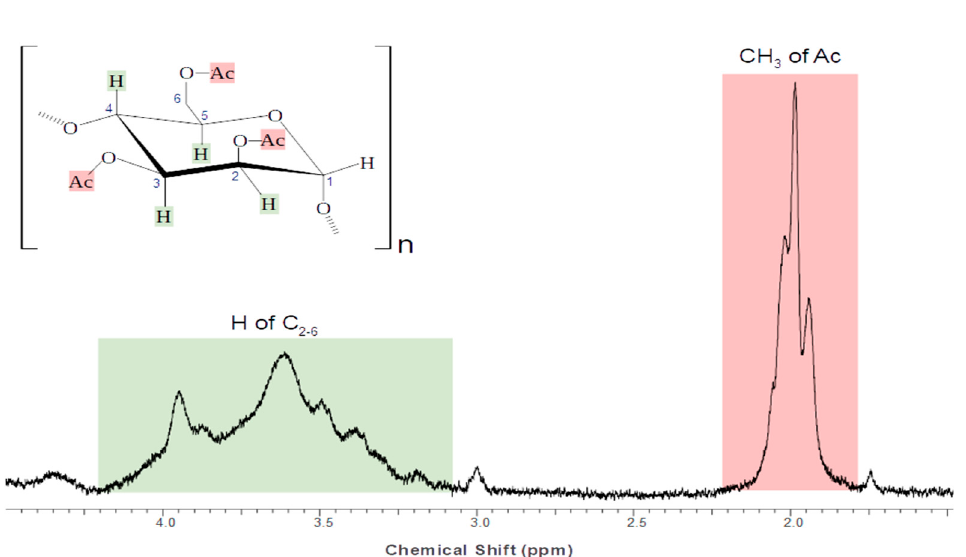
Figure 1. 1 H NMR spectrum (400 MHz) and peaks related to the monomeric glycoside unit ( ≈ 3.1 to